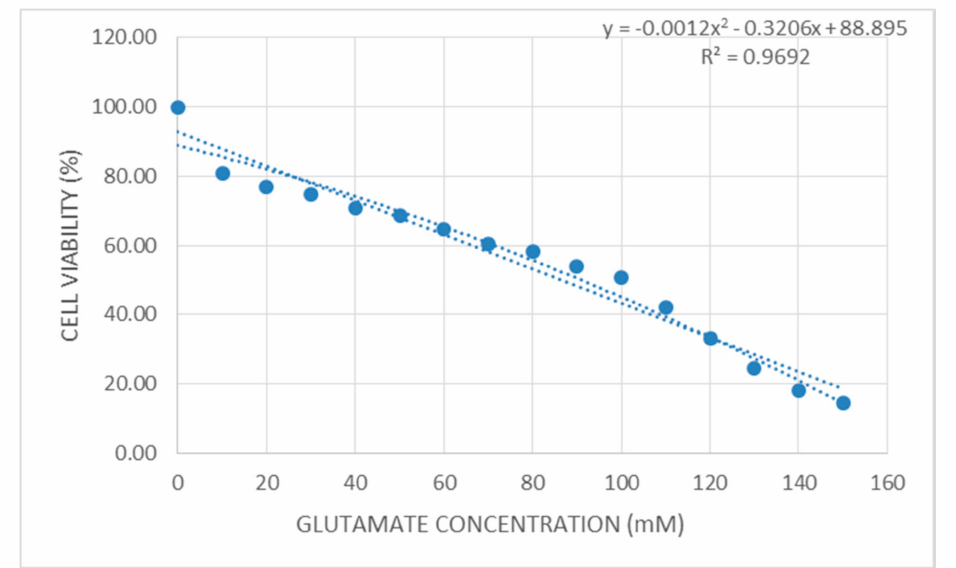
Figure 2. The effect of various concentrations of glutamate on primary astrocyte cells. Cultures were treated with various concentrations of glutamate for 24 h, y is showing the cell viability, x is showing the glutamate concentration and R 2 is showing coefficient of determination. IC 20 and IC 50 were calculated based on an equation with almost 97% accuracy. The figure shows 80% and 50% cell viability in 10 mM and 100 mM glutamate concentrations,